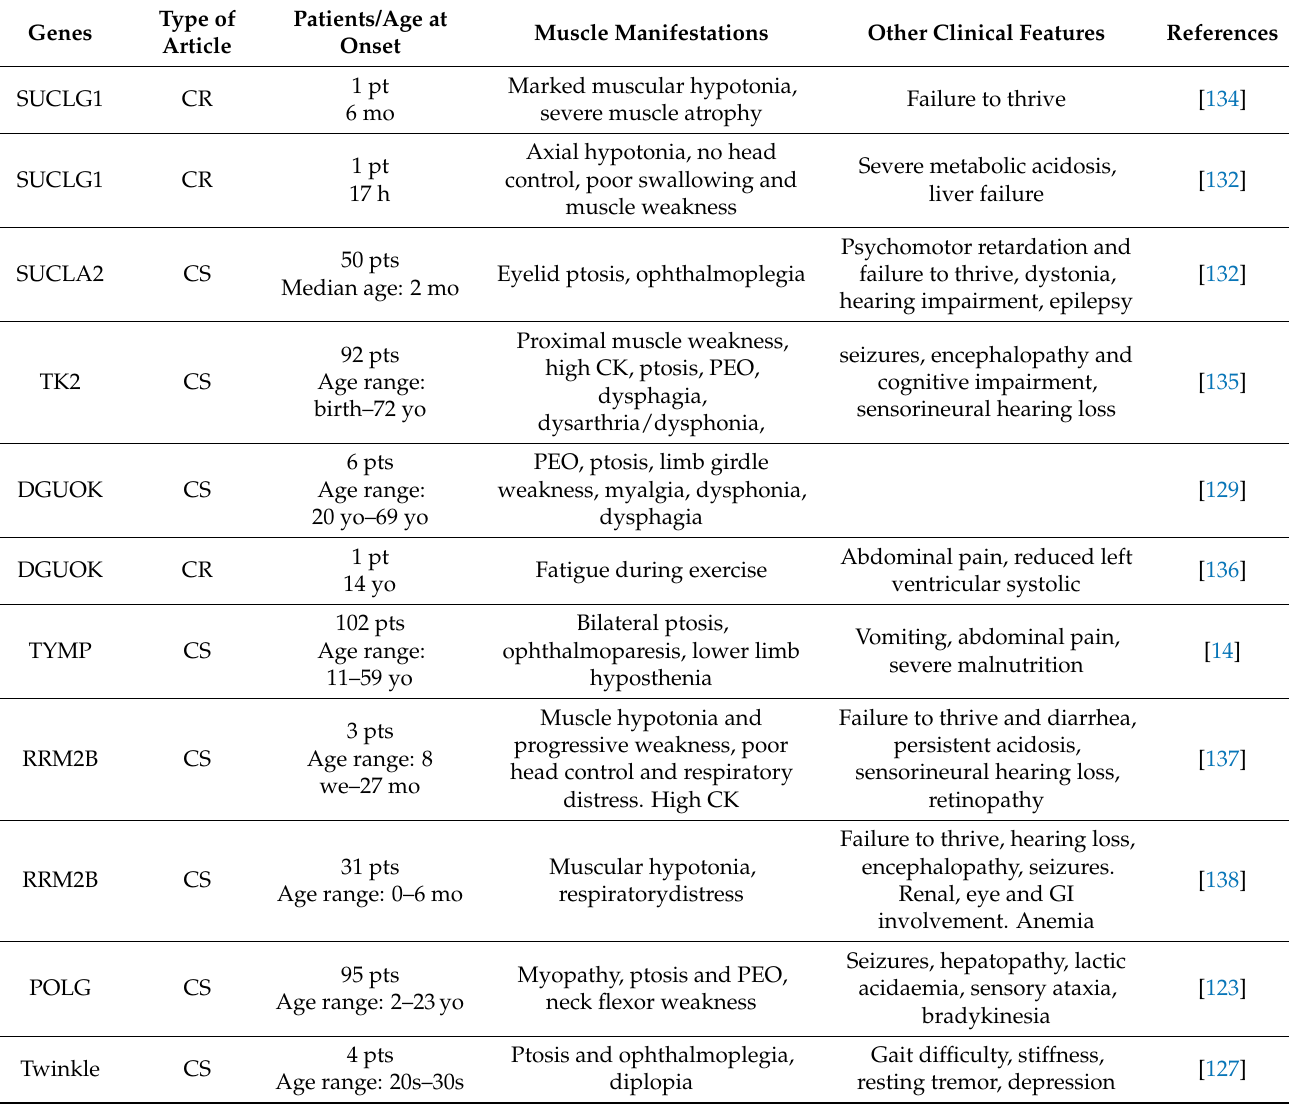
Table 4. Examples of defects in nuclear genes with a predominant muscular involvement